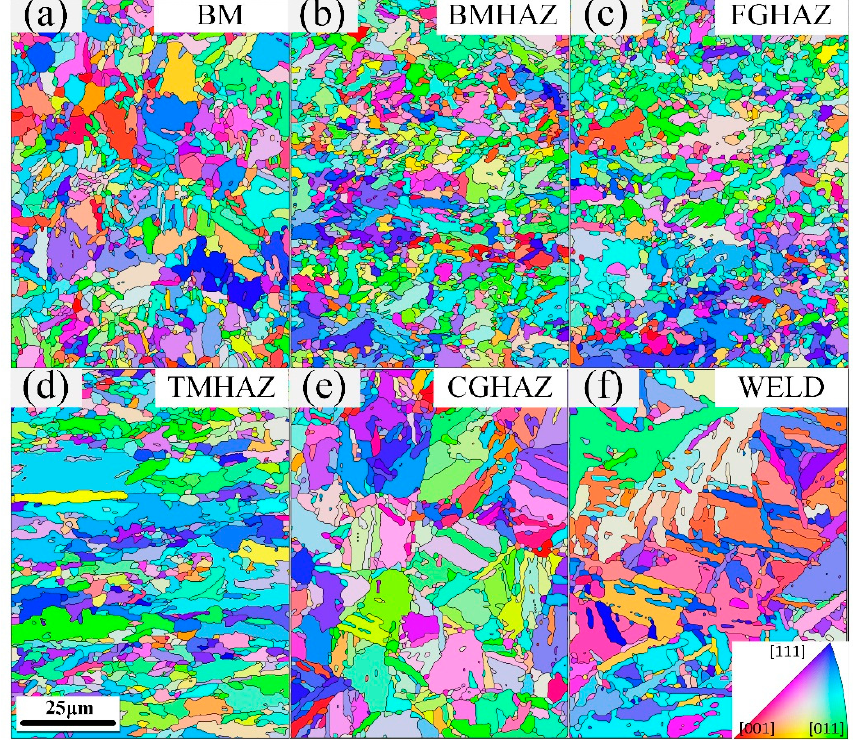
Figure 4. Grain orientation of each microstructural zone (from base metal (BM) to WELD) of the X100 laser-welded joint: ( a ) BM; ( b ) banded microstructure heat-affected zone (BMHAZ); ( c ) fine-grained heat-affected zone (FGHAZ); ( d ) transitional microstructure heat-affected zone (TMHAZ); ( e ) coarse-grained heat-affected zone (CGHAZ); ( f ) WELD.